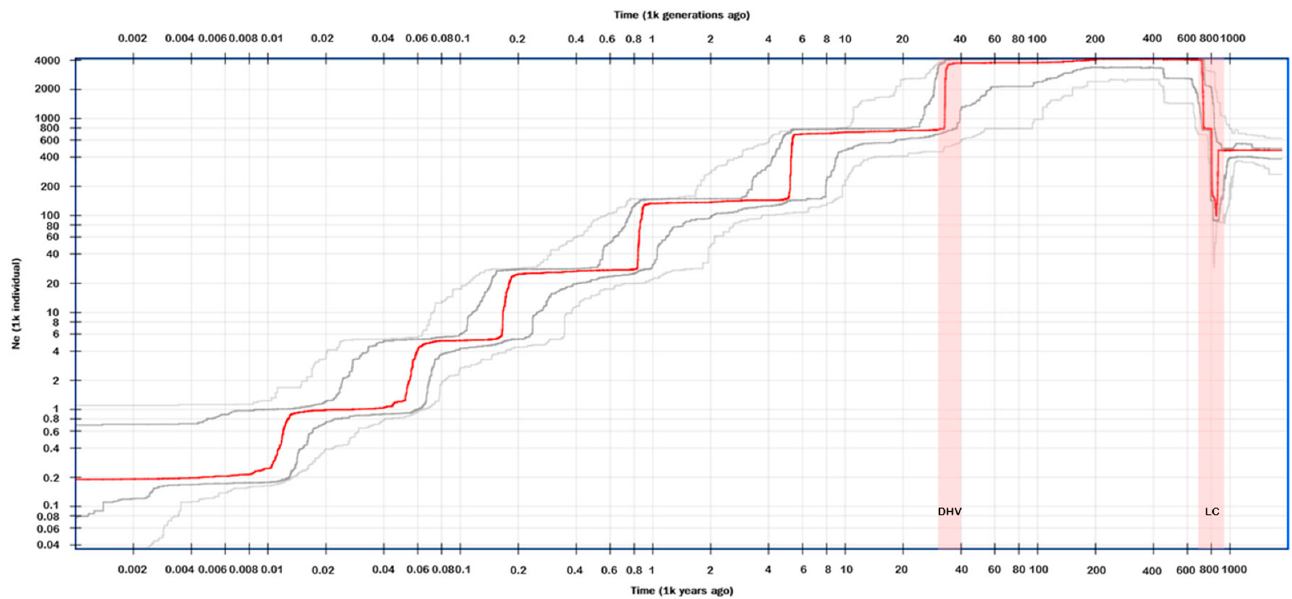
Figure 4. Historical fluctuation of effective population size of A. grevilleoides . Note: Red line: median of 200 inferences based on subsampling. Dark gray lines: 75% confidence interval of the inference. Light gray lines: 95% confidence interval of the inference. DHV: The first terraces in the dry-hot Valley; LC: the historical drainage capture events between the Luquan Wudongde and Jinpingzi.